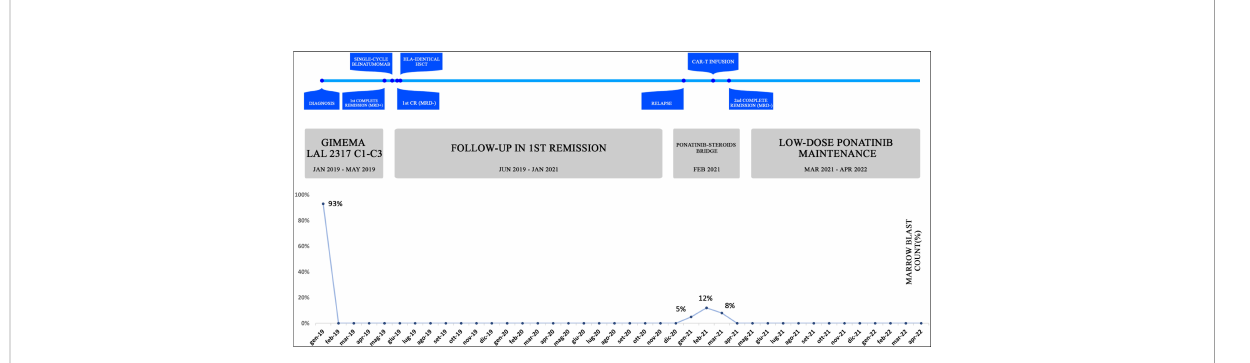
FIGURE 1 Case report timeline. The table offers an overview of the patient ’ s history, treatment lines (A) and corresponding marrow blast count (B) . The percentage of bone marrow blasts was evaluated at signi fi cant time-points, namely at diagnosis, post-induction, post-transplant, at disease relapse, during bridging and after CAR-T infusion. At the last follow-up, the patient is still in molecular remission and in persistent B-cell